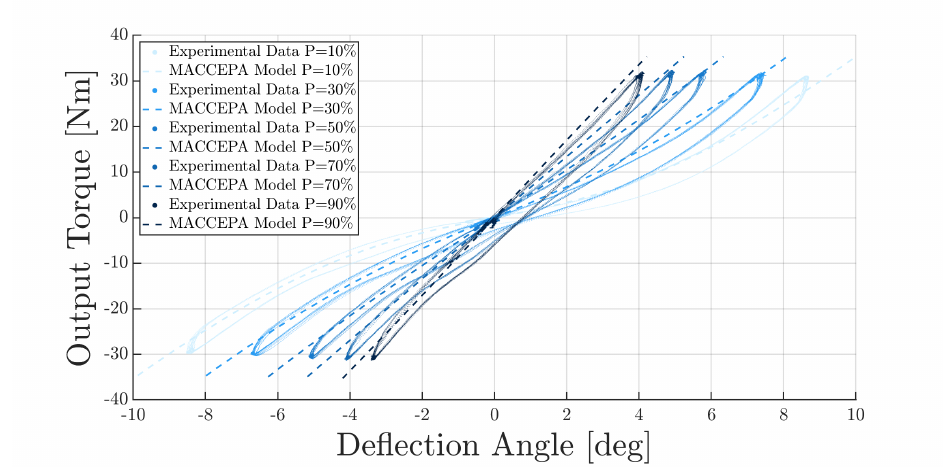
Figure 10. Torque-deflection characteristics of the SMARCOS. The points correspond to the ex- perimental data collected for different levels of spring pre-compression (light blue represents low pre-compression, dark blue is for higher pre-compression). The corresponding theoretical curves of the MACCEPA model are represented by the dotted lines. There is a good match between the data points and the model lines, except for the hysteresis phenomenon, which is not present in the model.